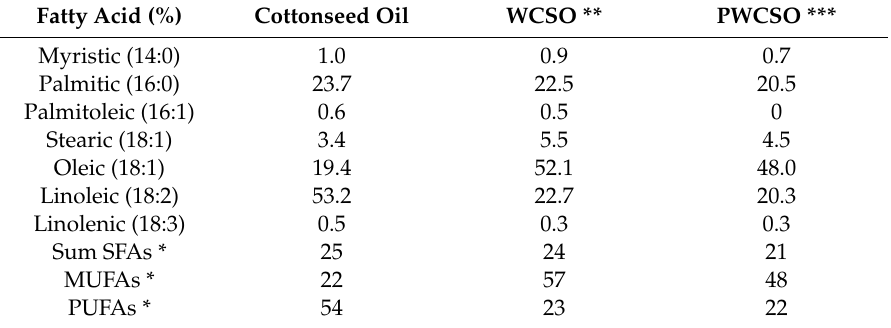
Table 2. Fatty acids profiles of the cotton seed oil, WCSO, and PWCSO.